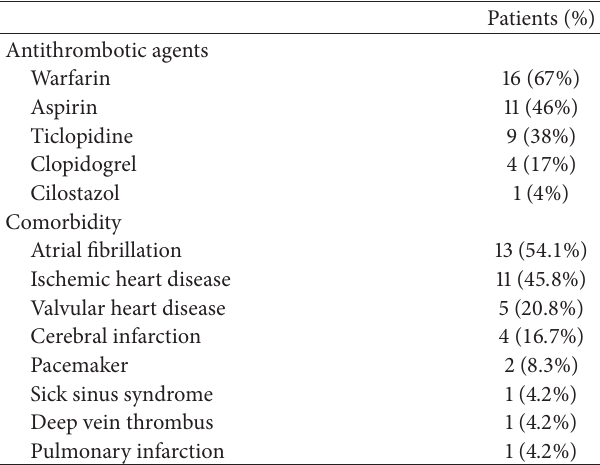
Table 1: Summary of antithrombotic agents and comorbidities of patients treated with ESD under HR.